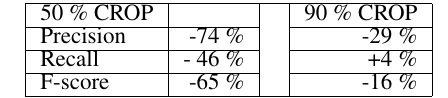
Table 5. Precision, recall and F-score for the